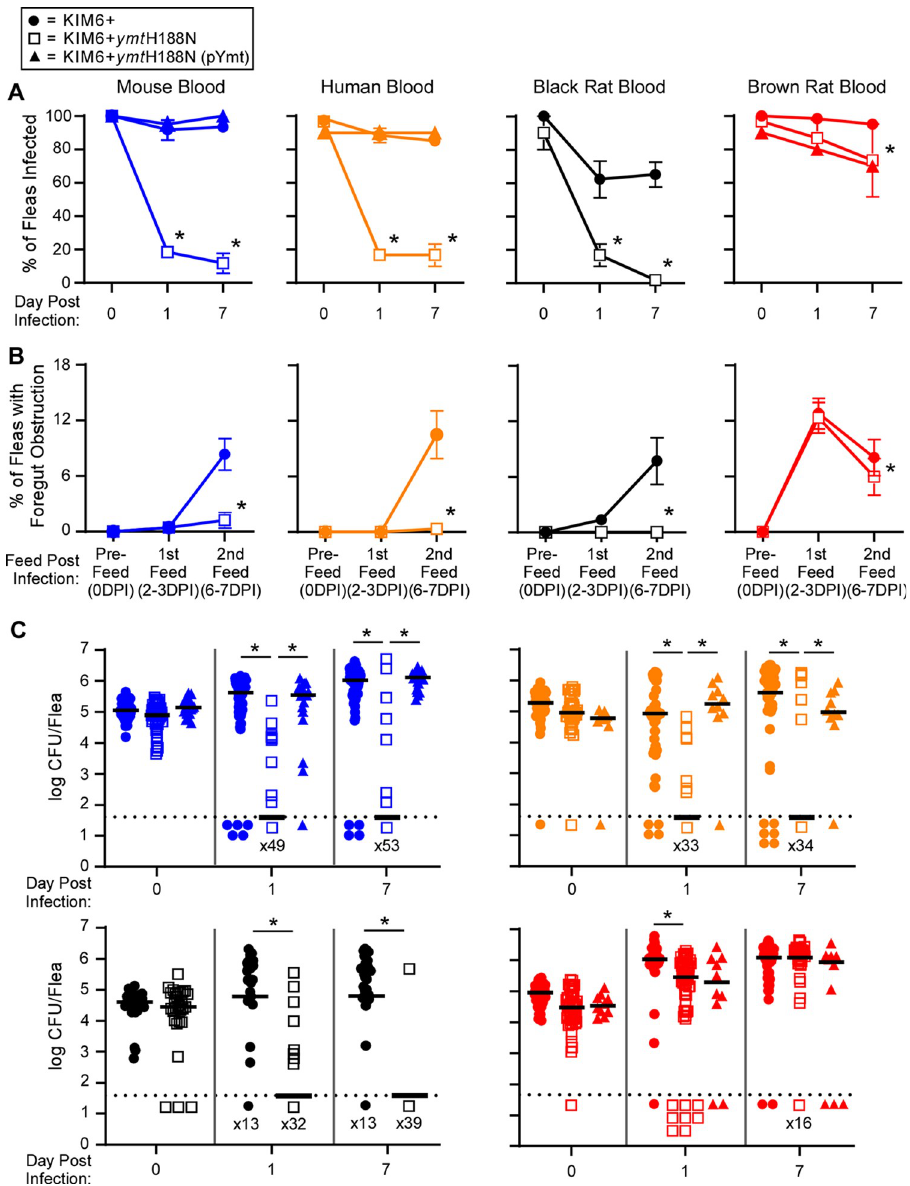
Fig 2. Ymt − and Ymt + Y . pestis colonize female X . cheopis similarly when brown rat blood is used for the infectious blood meal, but not if mouse, human, or black rat blood are used. Groups of female X . cheopis fleas that fed on mouse (blue), black rat (black), human (orange), or brown rat (red) blood containing 1.5x10 8 –1.1x10 9 CFU/ml Y . pestis KIM6+, KIM6+ ymt H188N, or KIM6+ ymt H188N (pYmt) were scored for 1 week for A) the percentage of fleas that remained infected; B) the percentage that developed obstruction of the foregut (partial or complete blockage) that interfered with normal blood-feeding; and C) bacterial burden. Data are cumulative from 3 (KIM6+ and KIM6 + ymt H188N groups) or 1 (KIM6+ ymt H188N(pYmt) groups) independent experiments. Samples consisted of 7–20 female (A and C) or 25–220 fleas (roughly equal numbers of males and females; B) per experiment. The mean and standard error (A, B) or median (C) are indicated. � p < 0.05 by chi-square (A, B) or by Kruskal-Wallis test with Dunn’s post-test (mouse, human, and brown rat groups) or Mann-Whitney test (black rat group) ( C ). Dotted lines indicate the limit of detection (40 CFU). KIM6+ ymt H188N(pYmt) was not used for black rat blood infections due to the limited availability of this